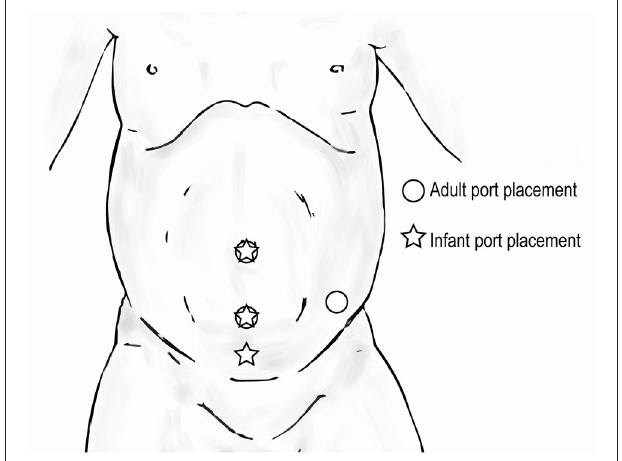
FIGURE 10 | Trocar positioning for upper urinary tract hidden incision endoscopic surgery (HIdES) in infants ( ) compared to that for adults (